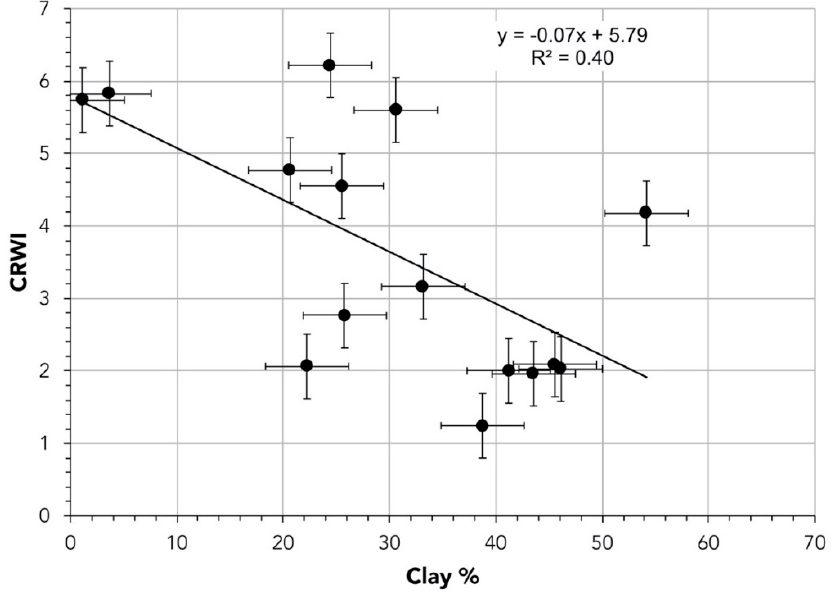
Figure 7. Relationship between continuum removed water index (CRWI) and ground control sample clay content. p = 0.01 .